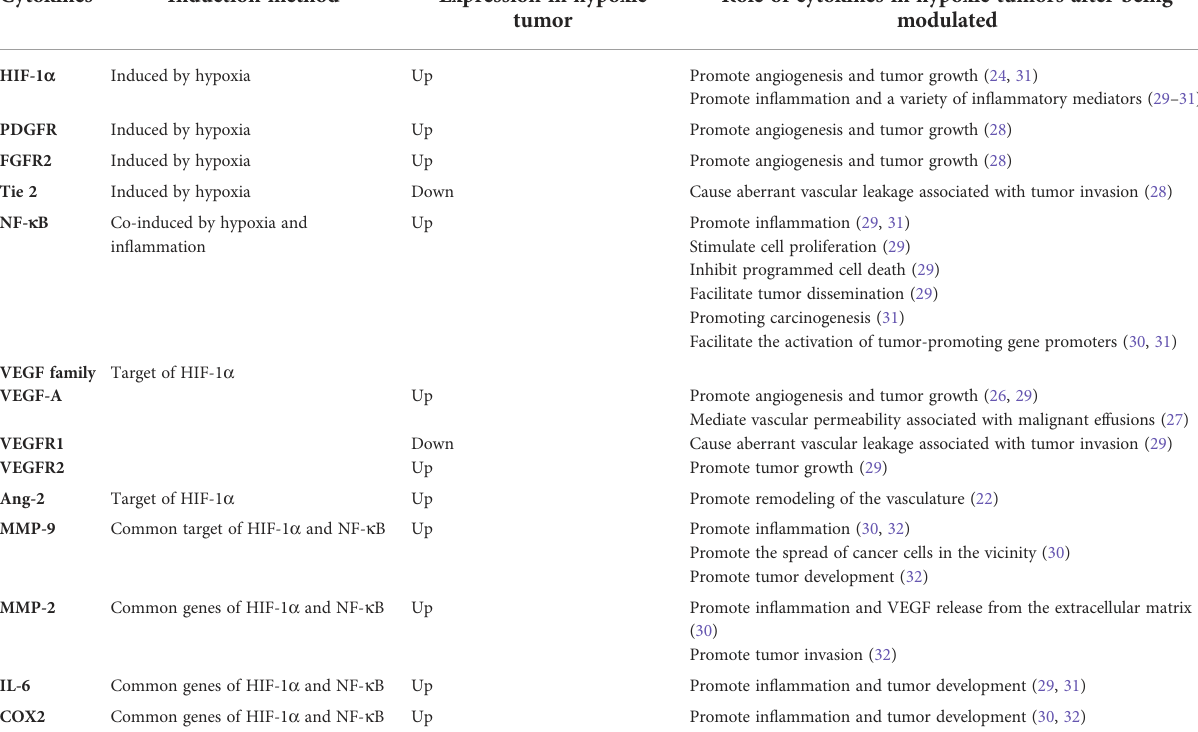
TABLE 1 Hypoxia and in fl ammation combined in